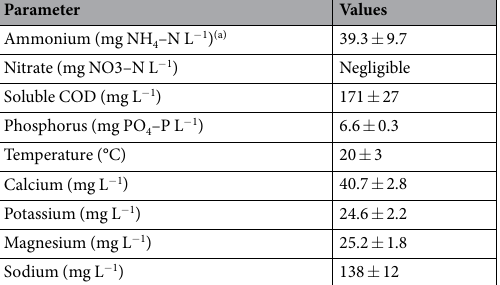
Table 1. Characterization of the domestic wastewater used in the experiments. a The value shown is the average NH4-N concentration of the sewage used in all experiments. In total, four batches of wastewater were used, one fresh batch for each set of experiment. Error estimates are standard deviation from all batches, measured in